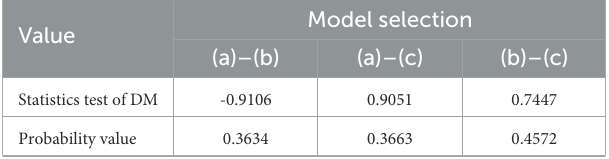
TABLE 14 The diebold-mariano